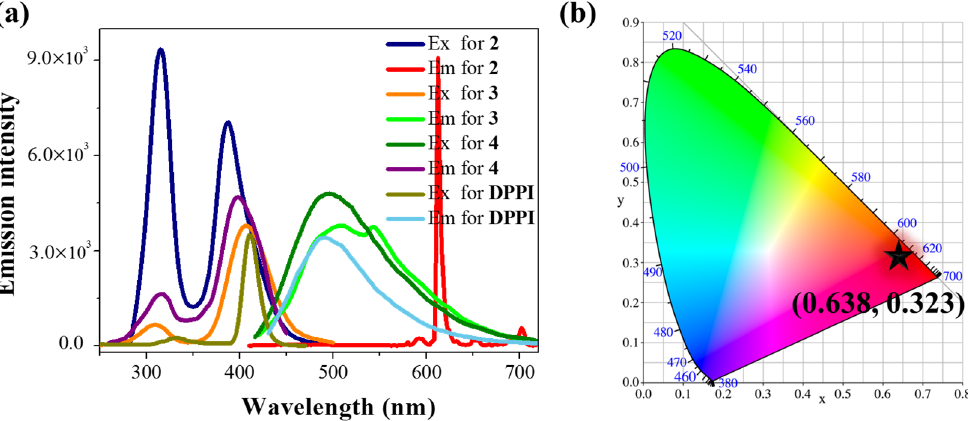
Figure 1. ( a ) Emission and excitation spectra of complexes 2 – 4 and DPPI and ( b ) CIE coordinates of complex 2 in DMSO solution (10 − 5 M) at room temperature (at around λ ex = 400 nm, and λ em = 612 nm for complex 2 , λ em = 545 nm for complex 3 , λ em = 495 nm for complex 4 and DPPI).